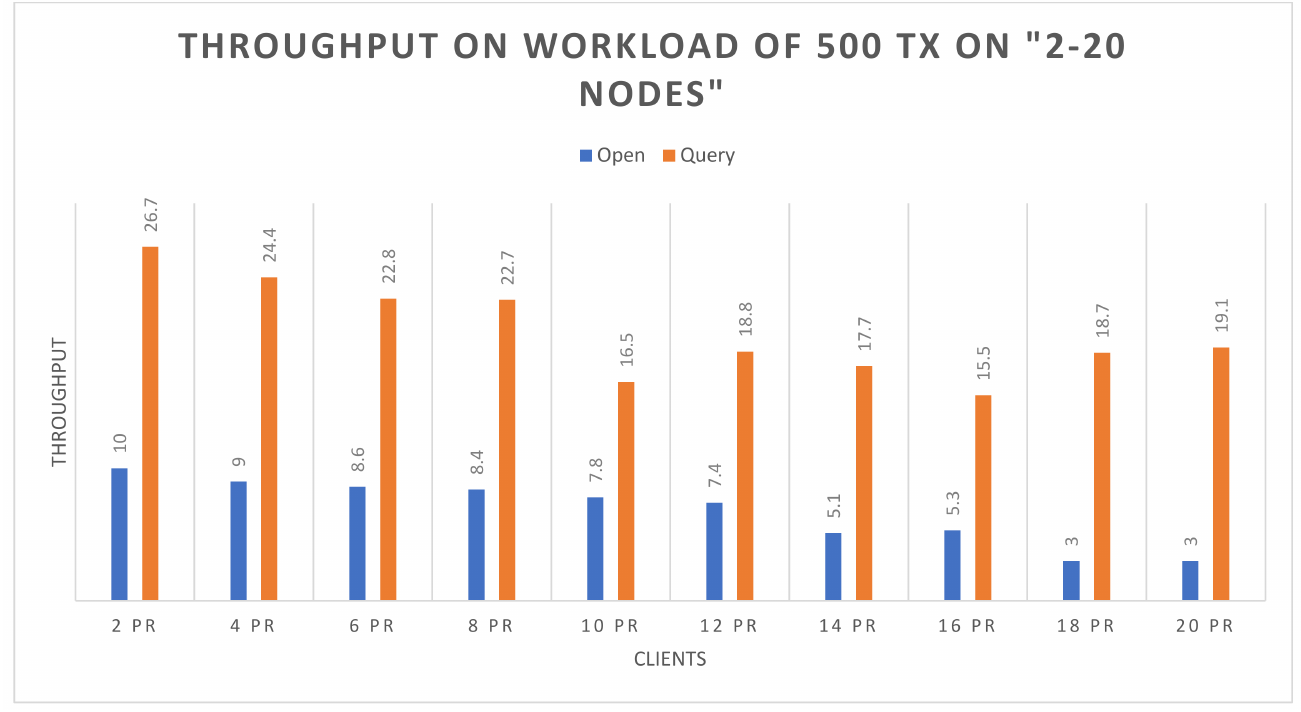
Figure 6. Throughput on 500 transactions.